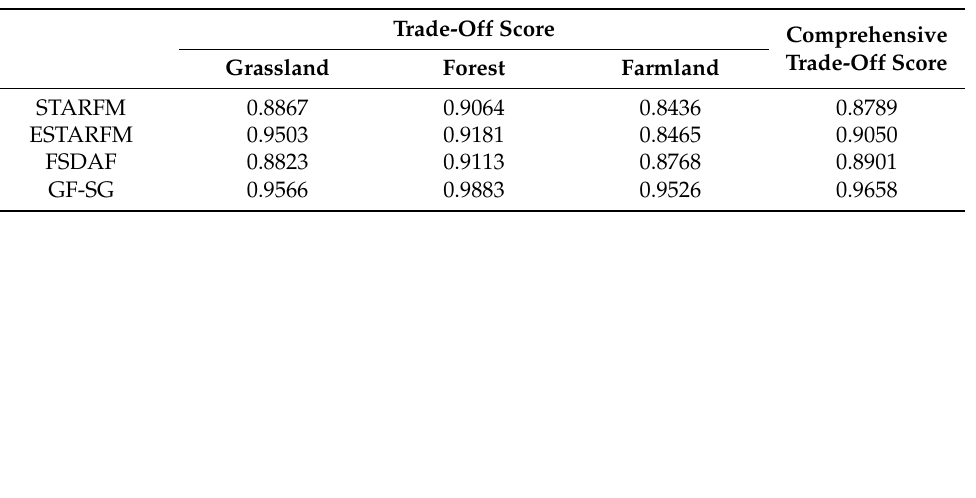
Table 4. The trade-off score and comprehensive trade-off score of the fusion